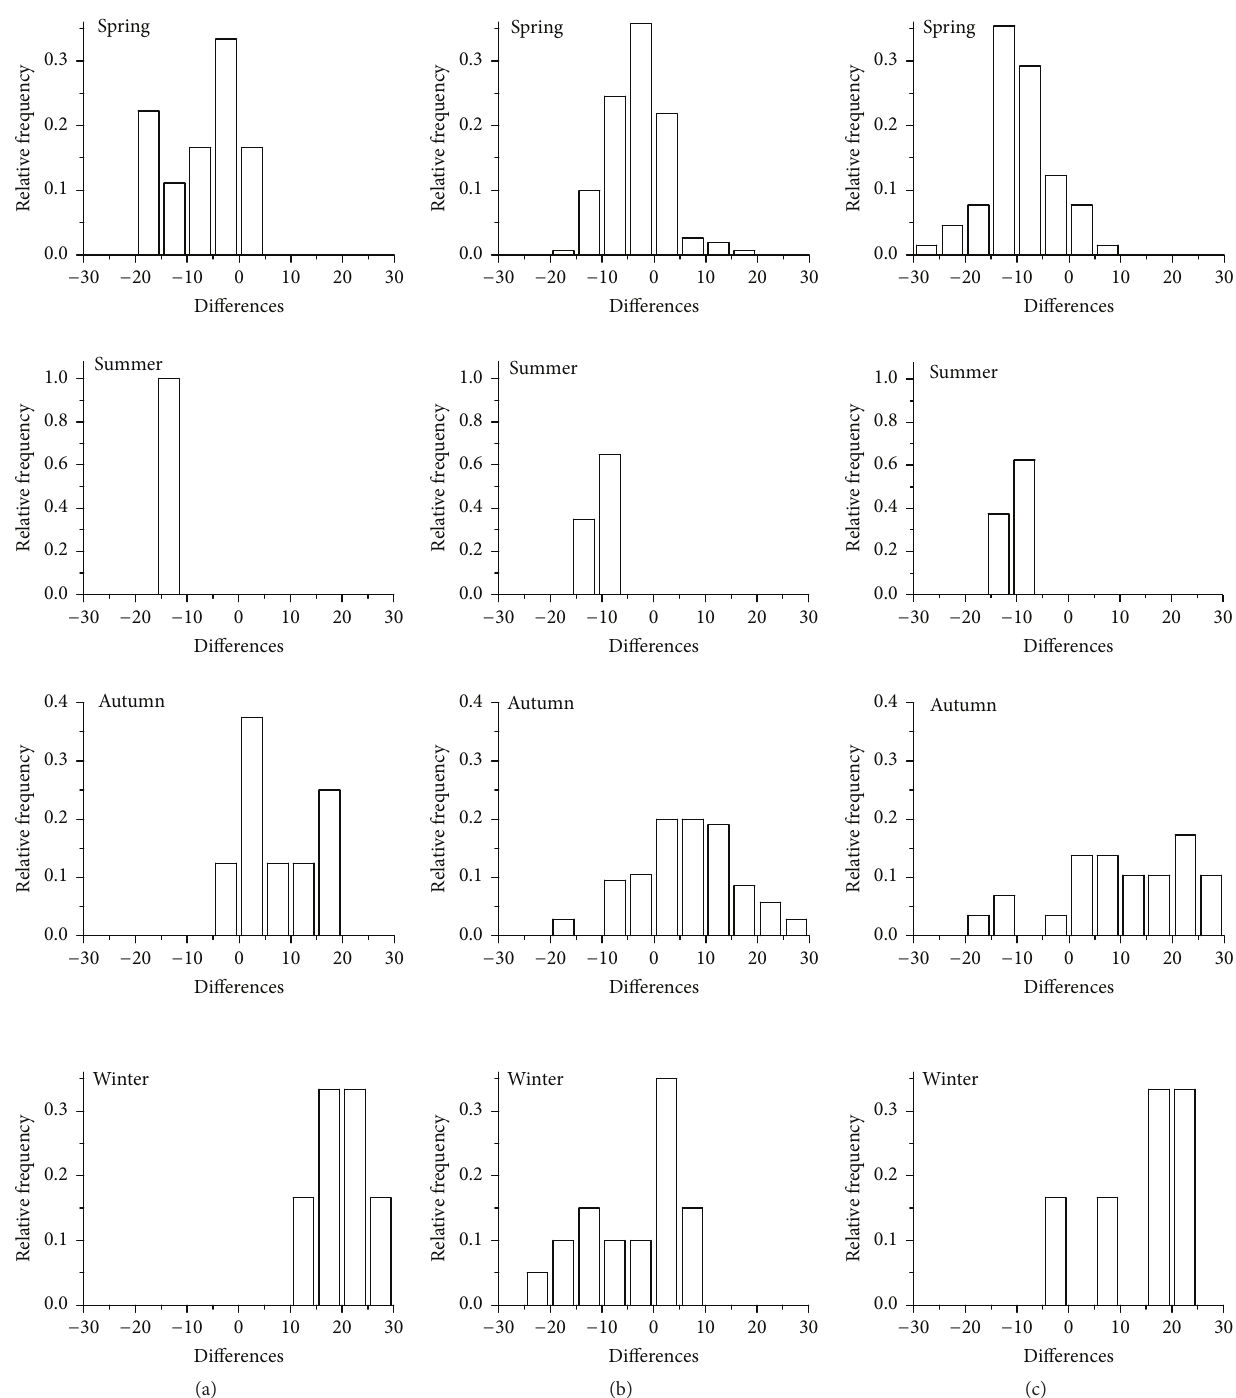
Figure 3: Frequency distribution of the differences in mean phenological dates between the phenological calendar of 1987–1996 and 2003– 2012. The columns stand for Shanghai (a), Nanjing (b), and Hefei (c),